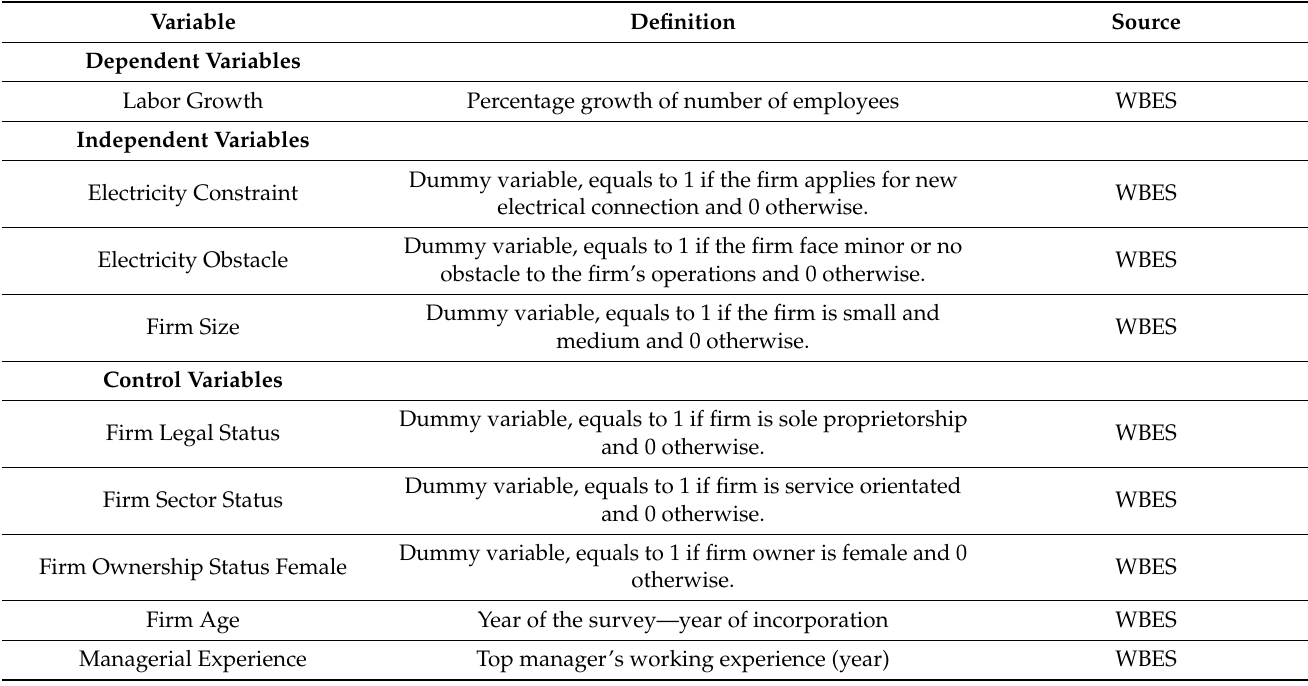
Table A1. Definition of